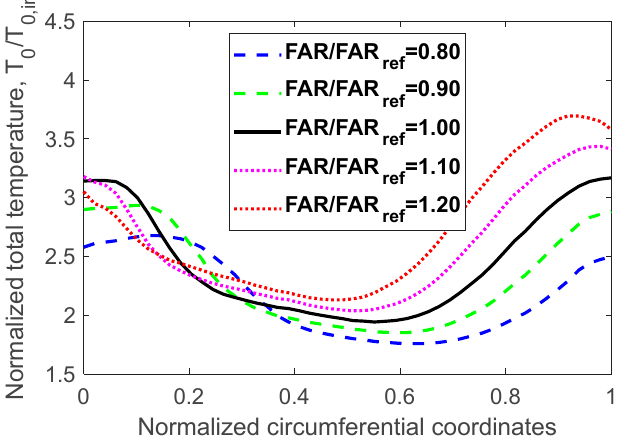
Figure 15. Total temperature circumferential distribution at the combustor outlet mid-span for different values of fuel-to-air ratio.